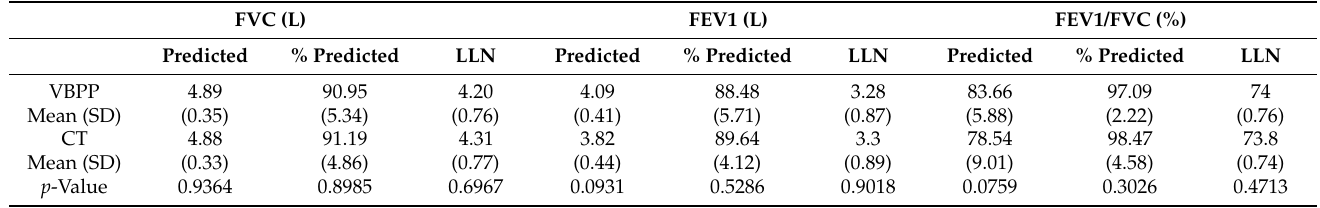
Table 2. Comparison of lung function after VBPP and CT treatment ( n = 15 patients per